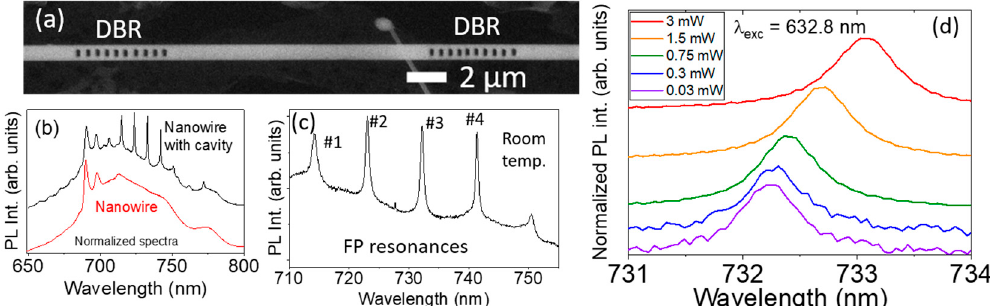
Figure 4. ( a ) SEM image of the microcavity patterned in a Cr-doped Ga 2 O 3 nanowire, with the two DBRs indicated. ( b ) Comparison between RT μ -PL spectra from an as-grown nanowire and the microcavity shown in ( a ). Spectra were normalized and vertically shifted for the sake of clarity. ( c ) Blow up from ( b ) of the four main F-P resonance peaks observed in the microcavity, overlapping the broad phonon-assisted band in the near-IR range. Their positions are 714.2 nm, 723.0 nm, 732.1 nm and 741.3 nm and were labeled #1, #2, #3 and #4, respectively. ( d ) Detail of the evolution of the #3 resonant peak when changing the excitation power. Table 2. Lorentzian fit parameters to PL curves excited with different powers, as shown in Figure 4d. Peak # T (K) Center